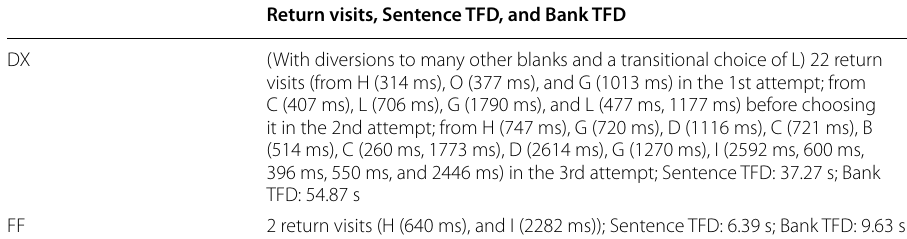
Table 6 Cognitive effort on local processing regarding Blank 8 Return visits, Sentence TFD, and Bank TFD DX (With diversions to many other blanks and a transitional choice of L) 22 return visits (from H (314 ms), O (377 ms), and G (1013 ms) in the 1st attempt;